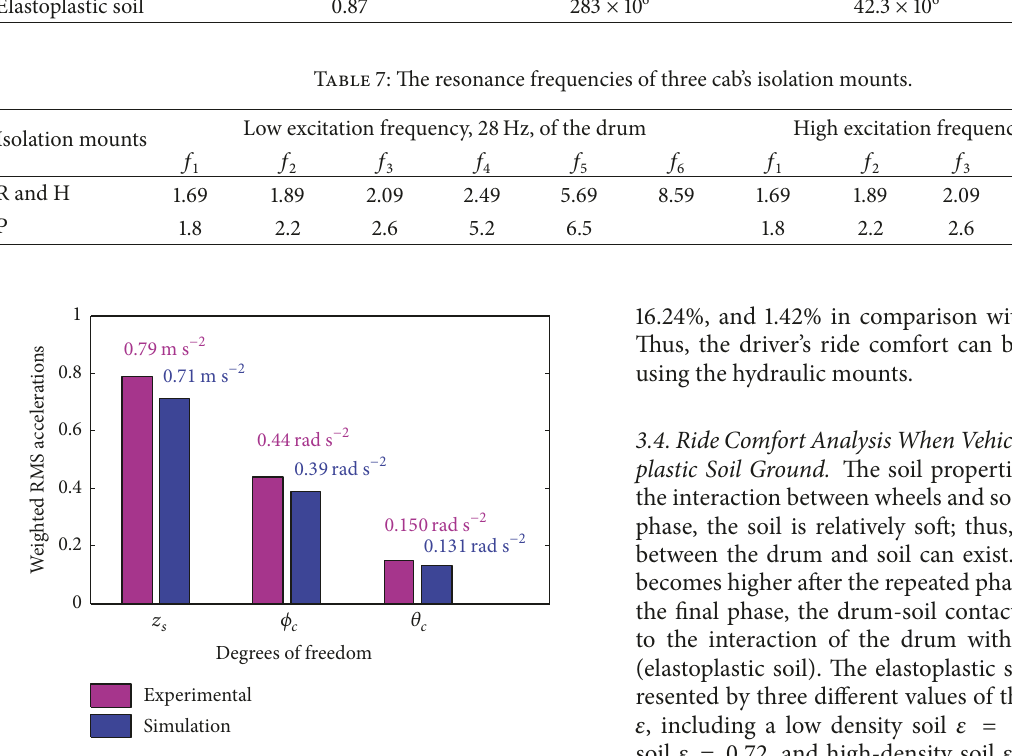
Figure 9: The weighted RMS acceleration responses under a low excitation frequency 28 Hz of the